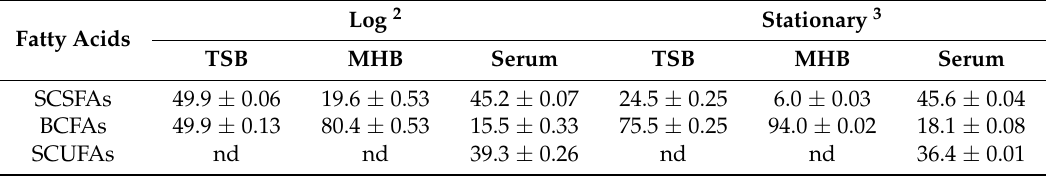
Figure 1. Staphyloxanthin production does not affect growth patterns of pigmented and non-pigmented S. aureus grown in various media. The strains were grown in TSB, MHB and serum and optical density (OD 600 ) was measured at intervals. Error bars indicate standard deviation on the mean OD 600 values determined from three independent growth experiments for each strain. Table 3. Fatty acid composition (%) 1 of a carotenoid-deficient strain Pig1 ∆ crtM grown in various media.